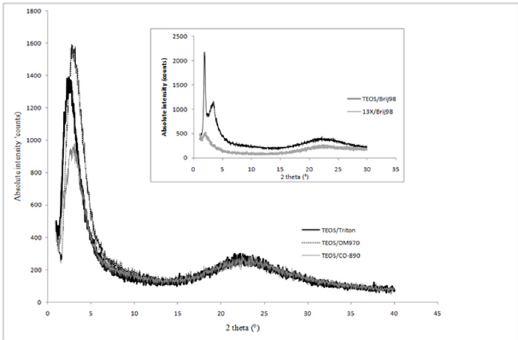
Figure 1. Low-angle XRD patterns of calcined samples Figure 2 shows the SEM images of calcined